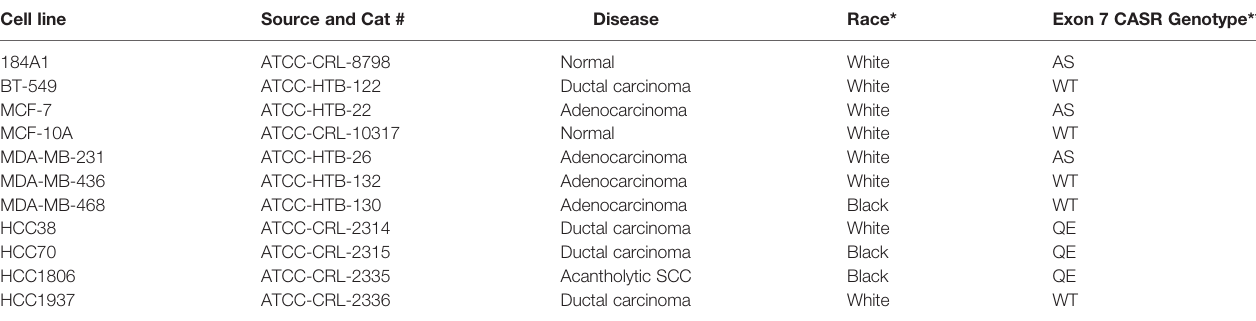
TABLE 1 | Calcium-sensing receptor Exon 7 variants in normal breast epithelial and breast cancer